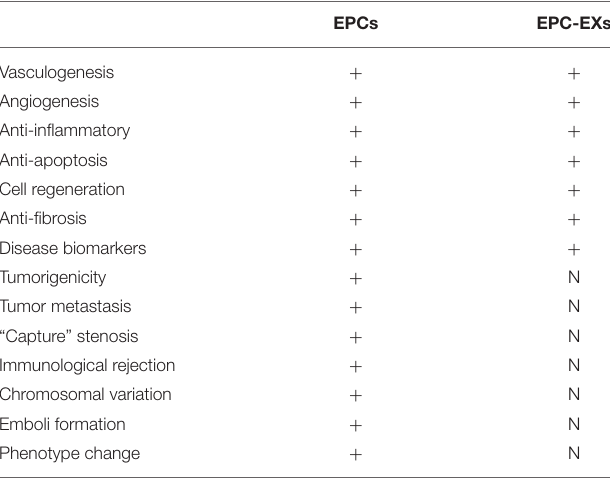
TABLE 1 | Comparison of EPCs and EPC-EXs in cell therapy. EPCs